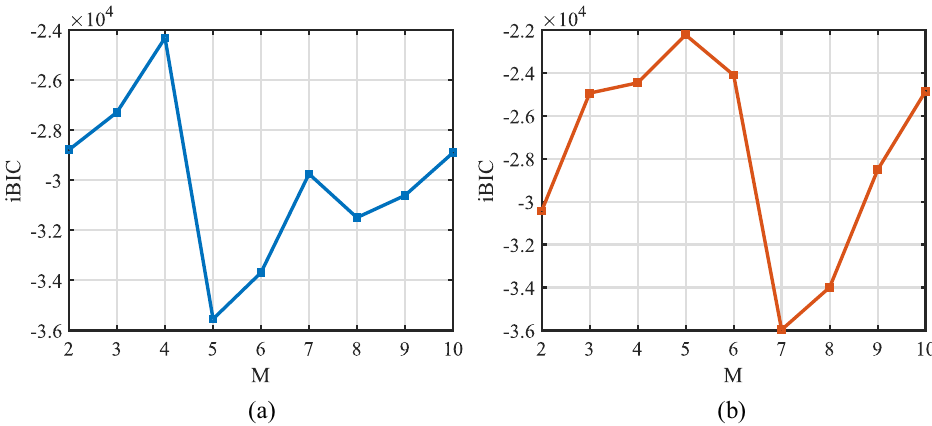
Figure 7: Demonstration of iBIC for vMF mixture model with respect to various choices of M on ( a ) carbon content and ( b )